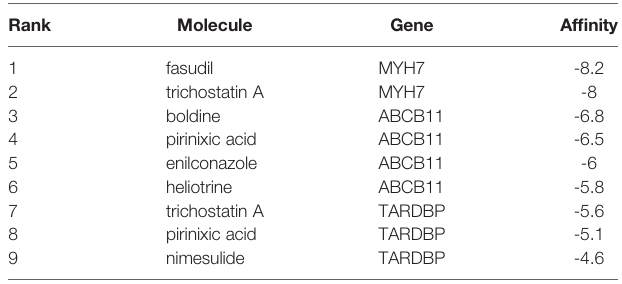
TABLE 4 | List of the best molecular docking model